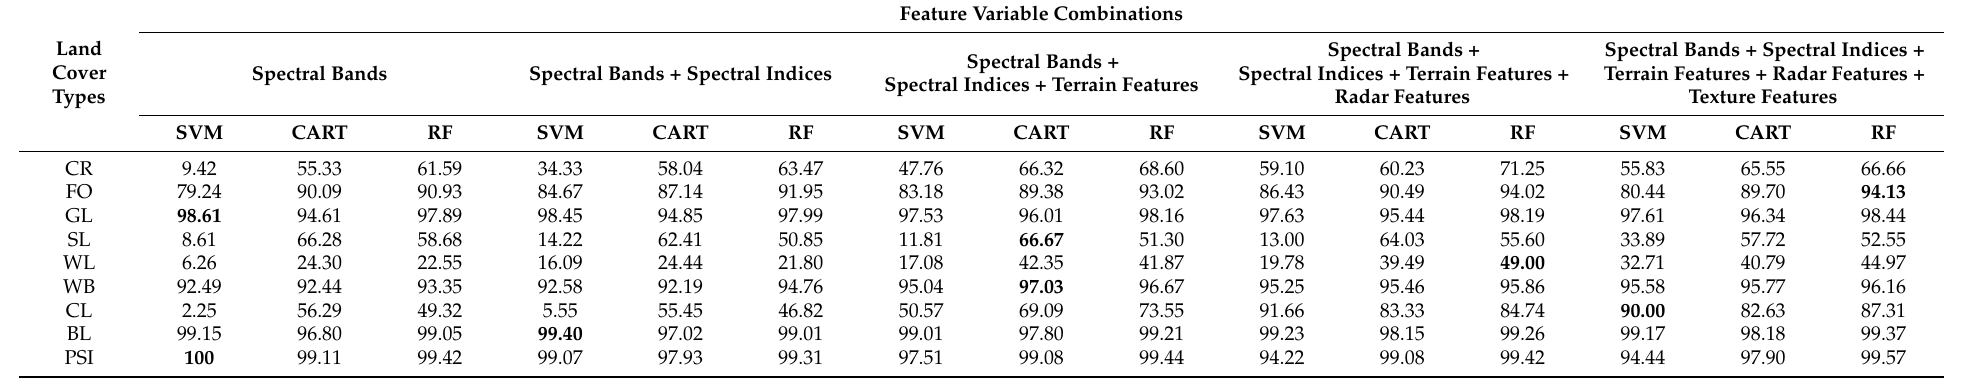
Table A2. Influences of the different feature variable combinations on the producer accuracies (PAs) (%) of the different land cover types.